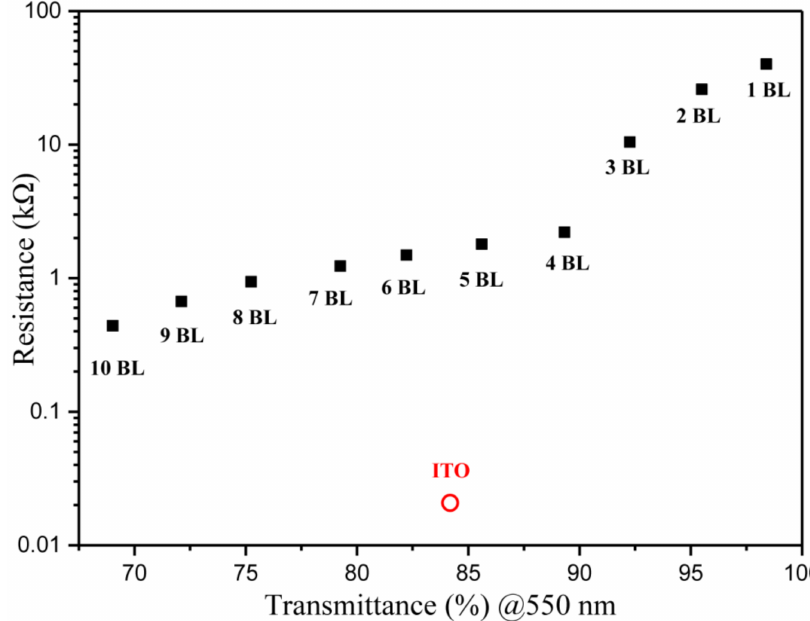
Figure 4. Optoelectronic performance (electrical resistance vs. optical transmittance at 550 nm wavelength) of [PDDA/(SWNT–DOC)] n thin films as a function of the number of bilayers deposited to 10